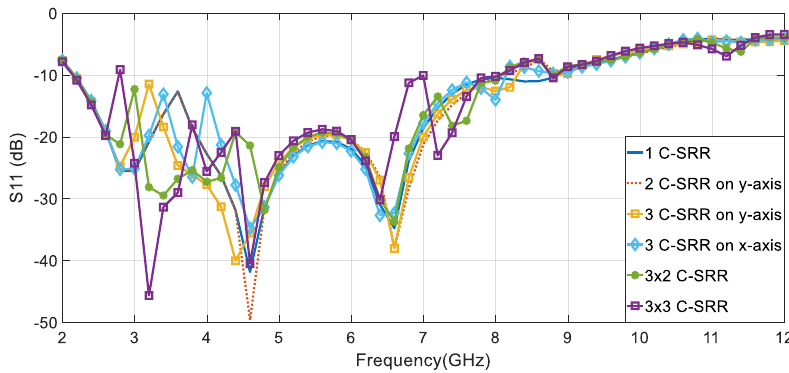
Figure 21. S 11 for antenna with different number of C-SRR.